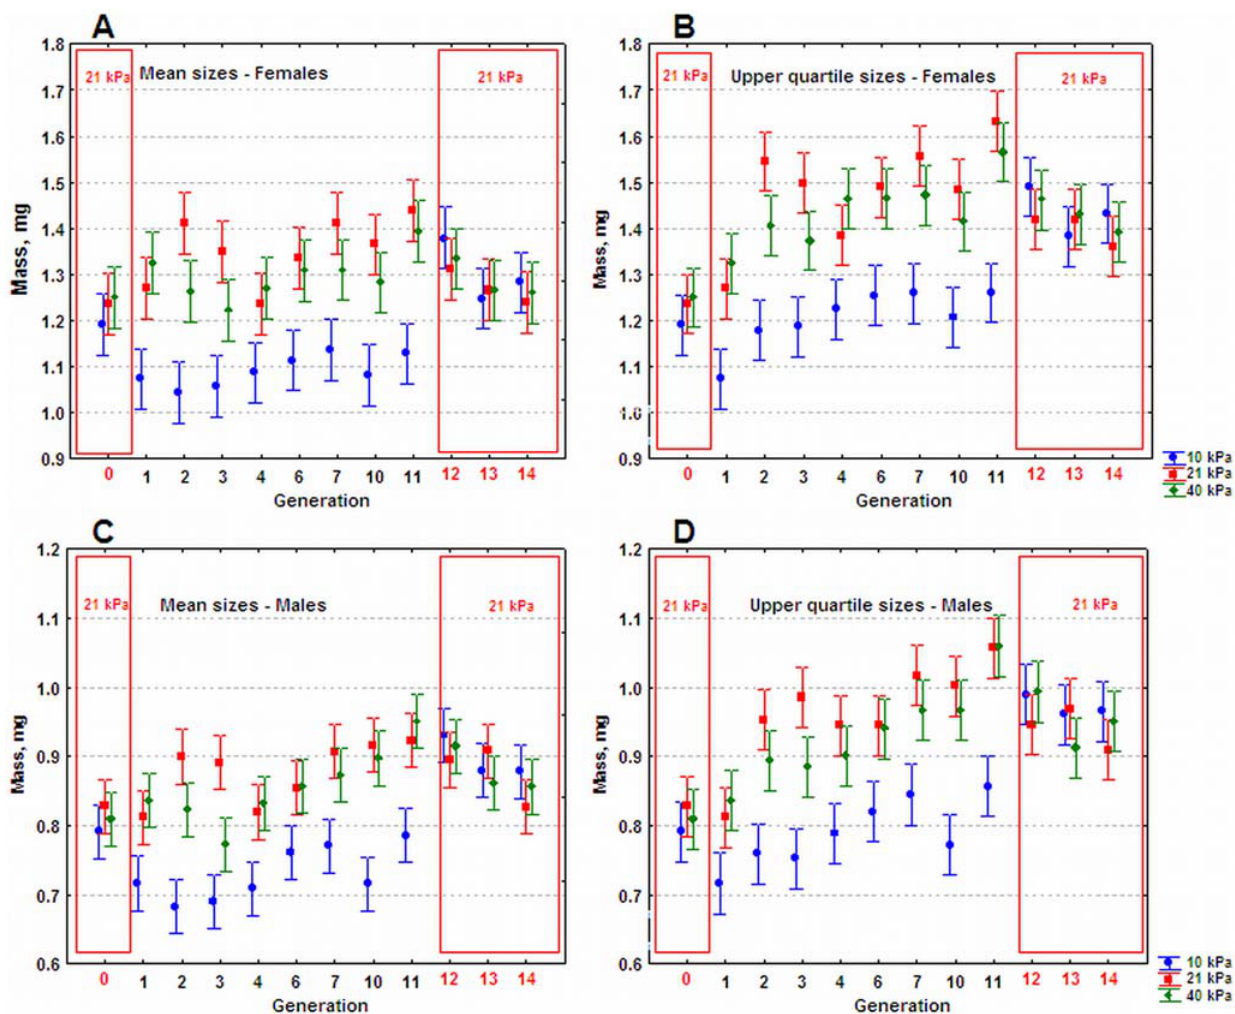
Figure 2. Plots of mass changes across generations. Mean adult masses (females above, males below) of five selected populations of Drosophila melanogaster (left), and mean masses of the largest quartile of those populations (values shown are the means 6 0.95 confidence intervals of the five population means for each treatment). Generation zero represents initial values of starting populations all reared in 21 kPa (included in red box). From generations 1–11, directional selection for large size was applied in either hypoxic (10 kPa, blue dots), normoxic (21 kPa, red squares) or hyperoxic (40 kPa, green diamonds) conditions. During generations 12–14, populations were returned to 21 kPa (included in red box) and no selection was performed. Non-overlapping 0.95 CI whiskers indicate significant differences. Due to questionable growth medium quality, generations 5, 8 and 9 were excluded from all analyses.